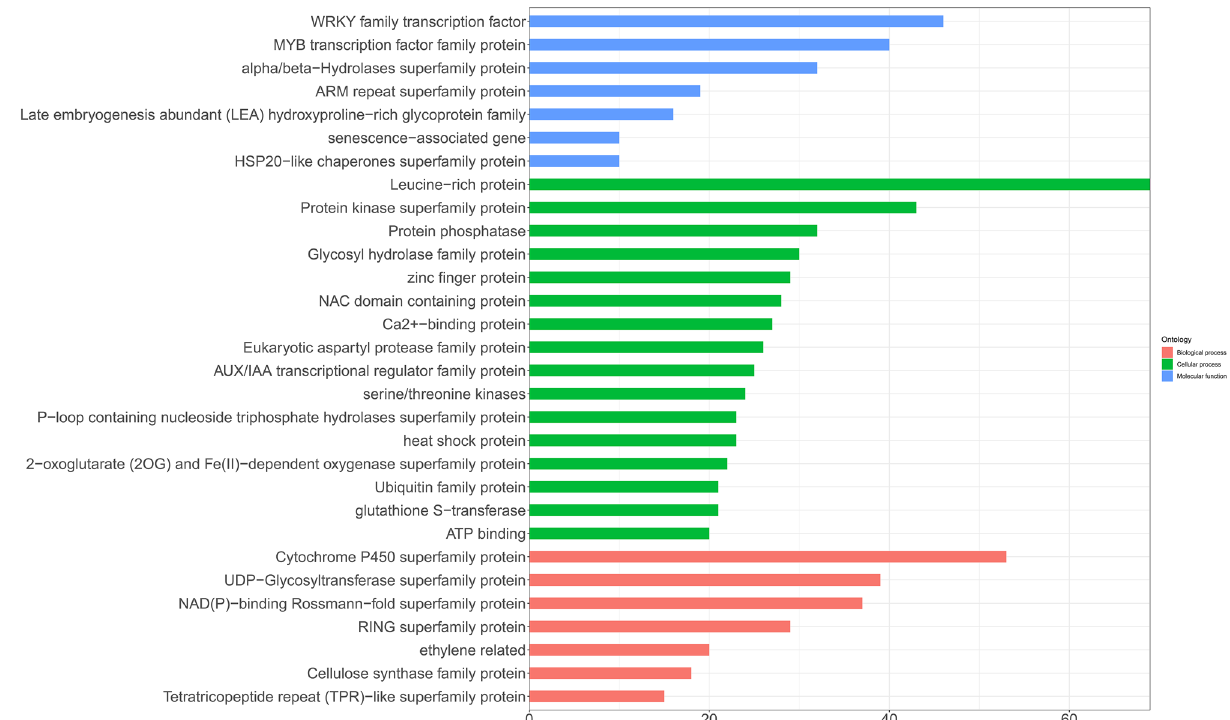
Figure 5. Gene ontology functional classification of DEGs drawn by ggplot2 (v3.3.3). X-axis represents the number of genes; Y-axis represents the GO terms names: red pillars represent biological process, green pillars represent cellular process, and blue pillars represent molecular